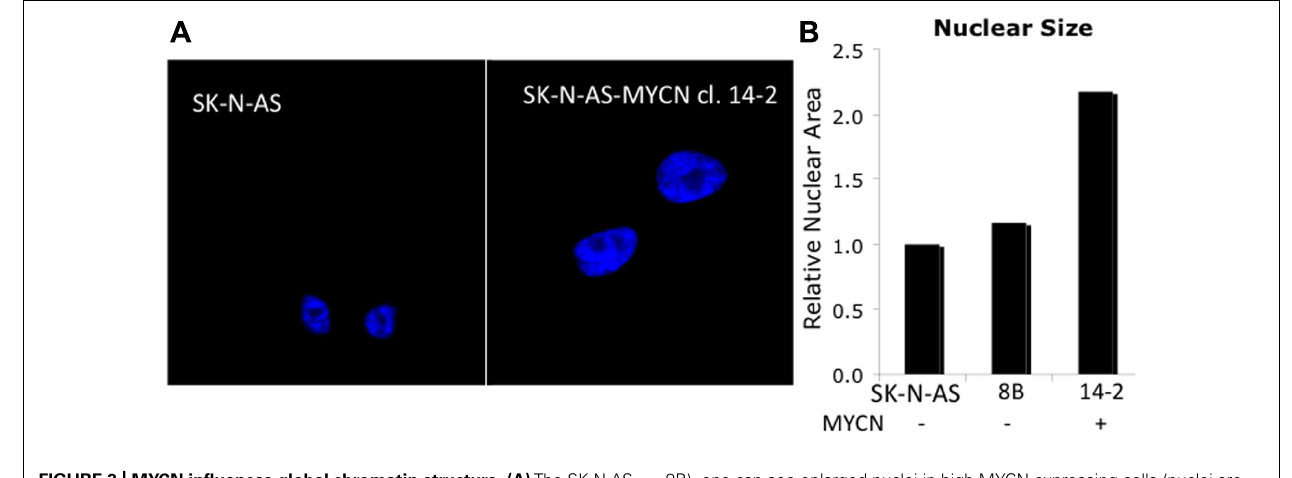
8B), one can see enlarged nuclei in high MYCN expressing cells (nuclei are stained with DNA binding dye DAPI). (B) Measurements indicate a twofold increase in nuclear